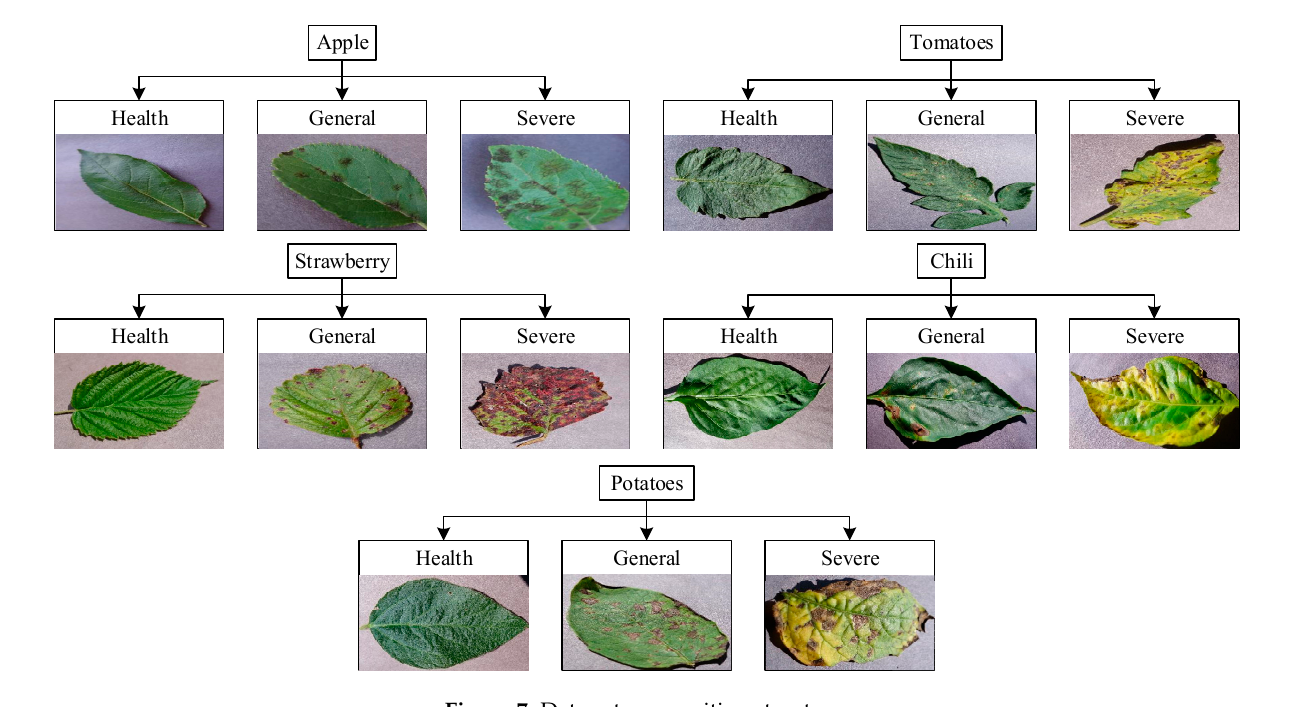
Figure 7. Data set composition structure.